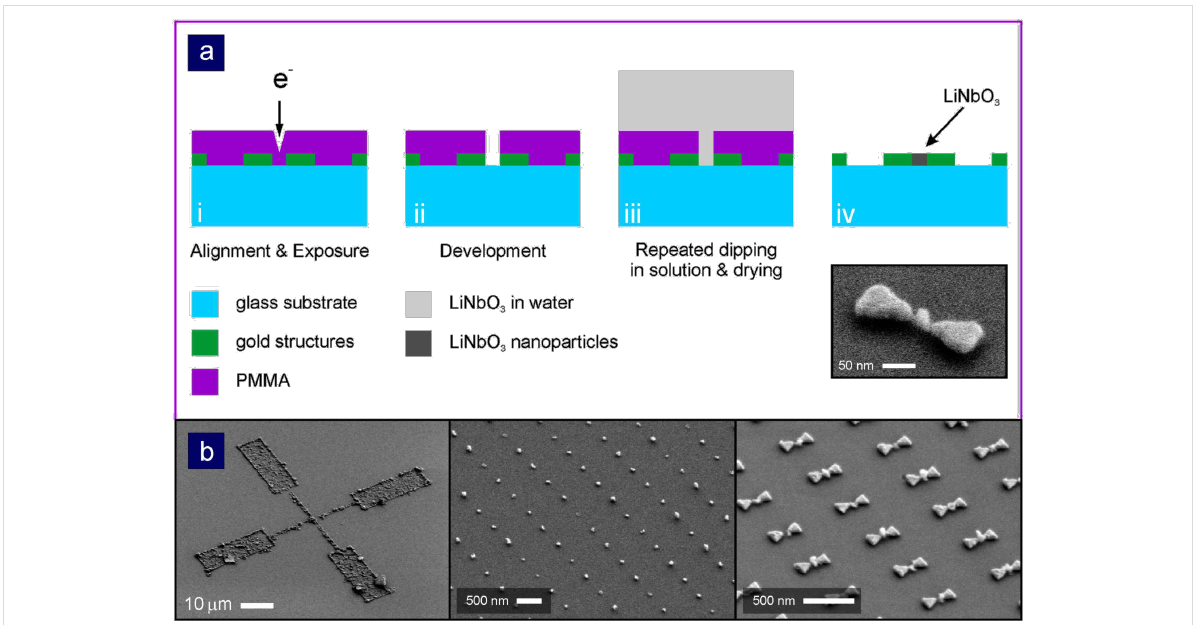
Figure 2: (a) Production steps for the selective filling of gap nanoantennas with LiNbO 3 nanocrystals. (i) In the first step a substrate with gold nanoan- tennas and alignment marks is covered with PMMA. After careful alignment, openings are defined within the resist layer directly above the gap regions of the antennas. (ii) The sample is developed and oxygen-plasma cleaned. (iii) The sample is dipped into a solution of LiNbO 3 nanocrystals and water and afterwards blown dry using nitrogen. This routine is repeated until additionally defined large openings appear to be filled (optical micro- scope inspection), see first image in (b). (iv) After lift-off, only the LiNbO 3 nanocrystals deposited inside the antenna gaps remain. Right bottom picture in (a) is a close-up SEM micrograph of a single structure. (b) Overview SEM micrographs of fabricated structures (after lift-off). Left: Cross-mark consisting of nanocrystals. Middle: Reference array of LiNbO 3 nanocrystals. Right: Selectively filled, LiNbO 3 nanocrystal, bowtie nanoantenna array. Figure adapted from